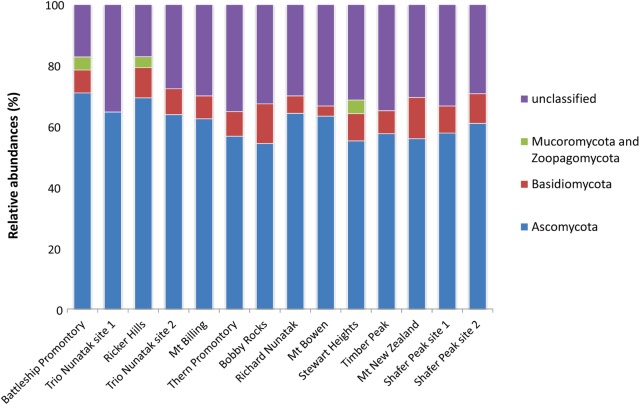
Relative abundances of the dominant fungal OTUs in the cryptoendolithic communities in Victoria Land, Antarctica. All relative abundances are based upon the sequences identified at the Phylum level.